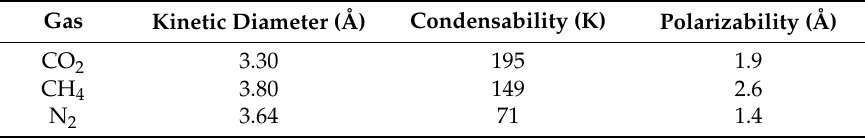
Table 5. Kinetic diameter and condensability of